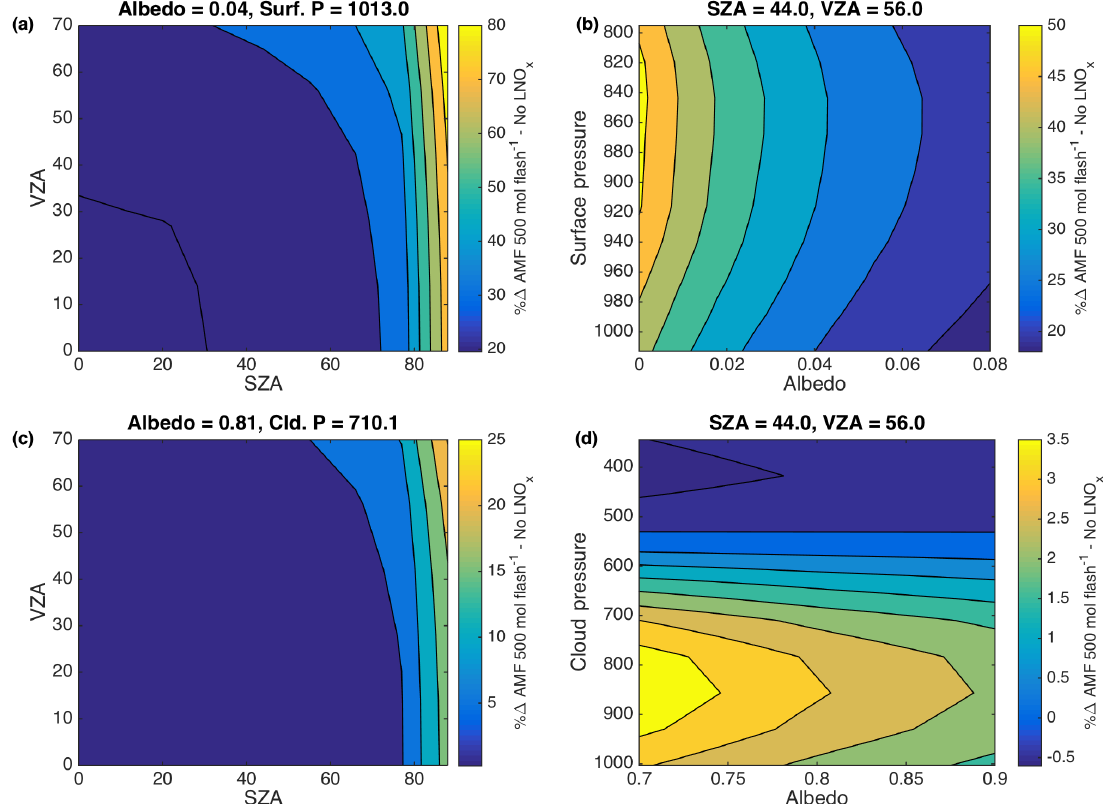
Figure 2. Contour plots of the percent change in the AMF when changing from the mean profile without lightning NO x to the mean with lightning NO x (500molflash − 1 ), averaged over the whole WRF-Chem domain. The differences are averaged over all values of RAA. In each plot, two parameters are varied while the other two are held constant. The values of the constant parameters are given above each plot. Panels (a) and (b) use a range of albedos and surface pressure representative of clear pixels; panels (c) and (d) use a range of albedos and cloud pressure representative of cloudy